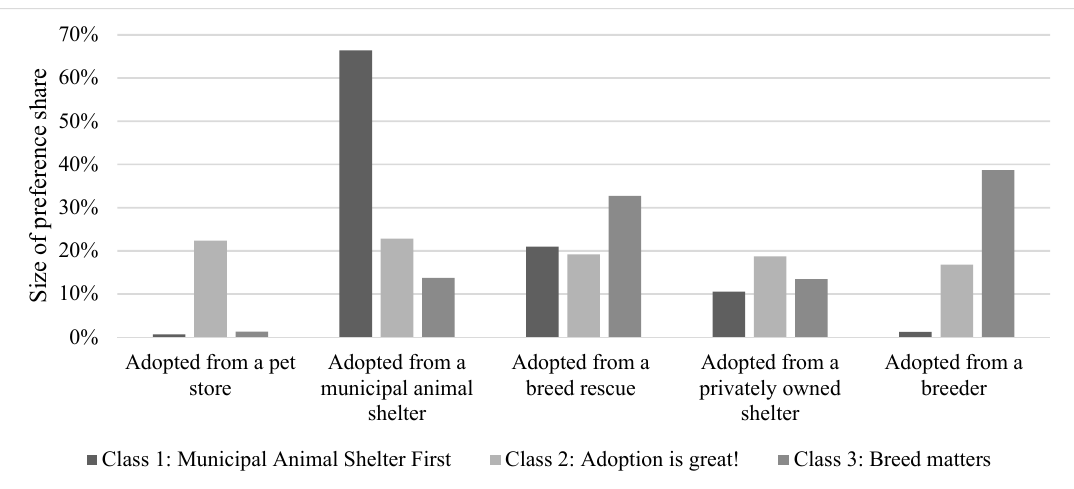
Figure 1. Random parameters logit model preference shares for most ethical way to adopt a dog (n = 767).